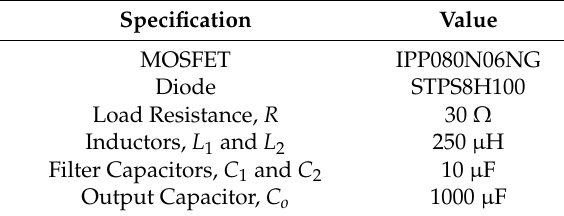
Table 4. Parameters of